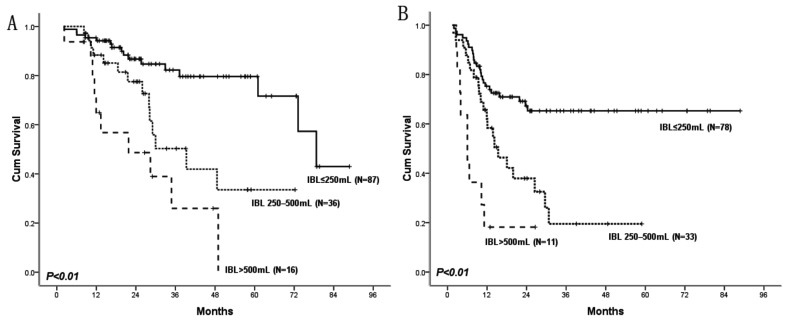
Dose–response relationship between IBL, OS (a), and RFS (b).OS and RFS decreased significantly with increasing IBL volumes. The 5-year OS of patients with IBL≤250mL, 250–500mL, and >500mL were 71%, 33%, and 0%, respectively (P<0.01). RFS of patients within the three IBL volumes at the end of the first year were 67%, 38%, and 18%, respectively (P<0.01).